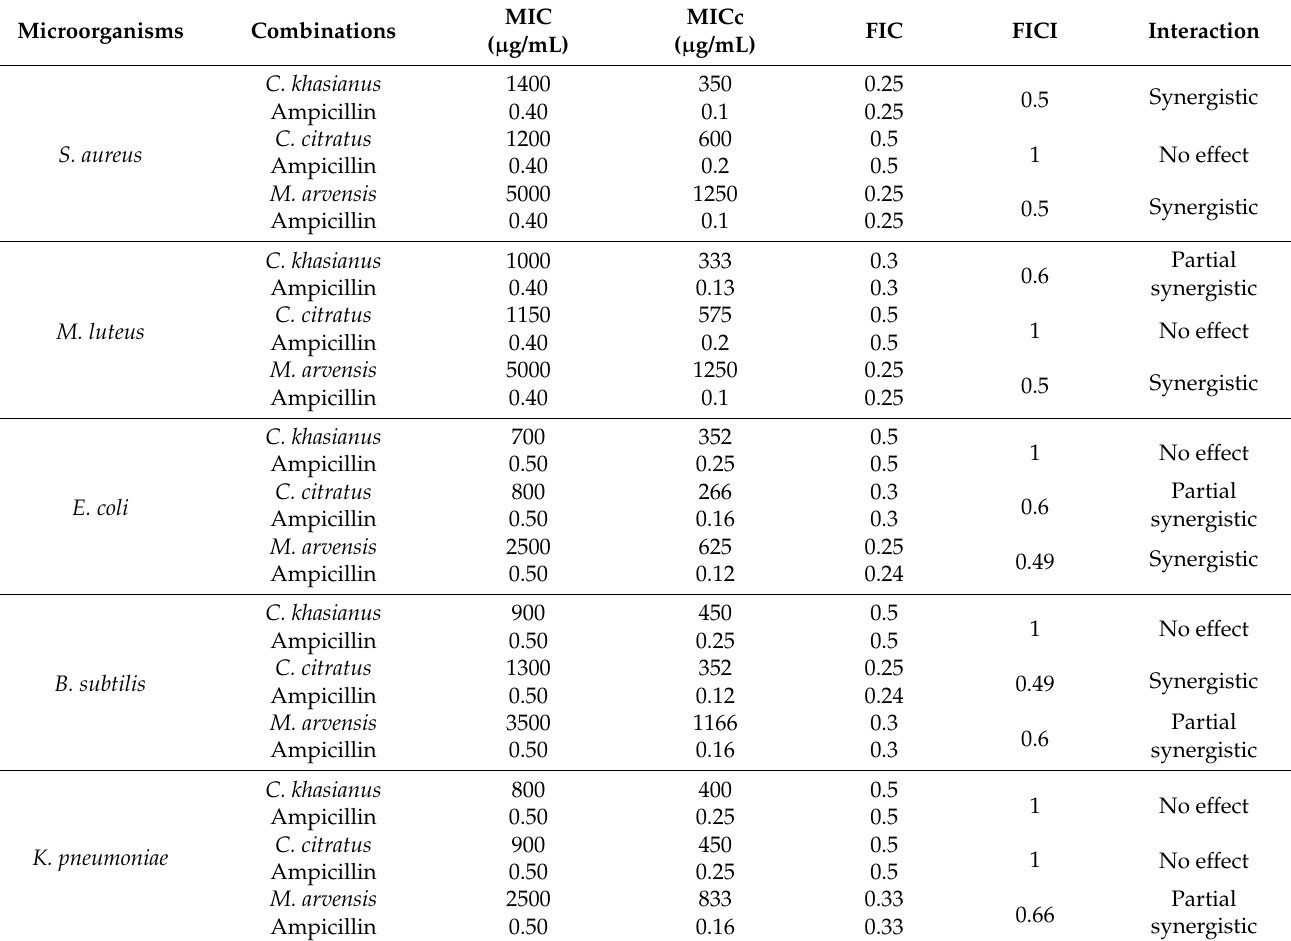
Table 4. Effect of combinations between essential oils and